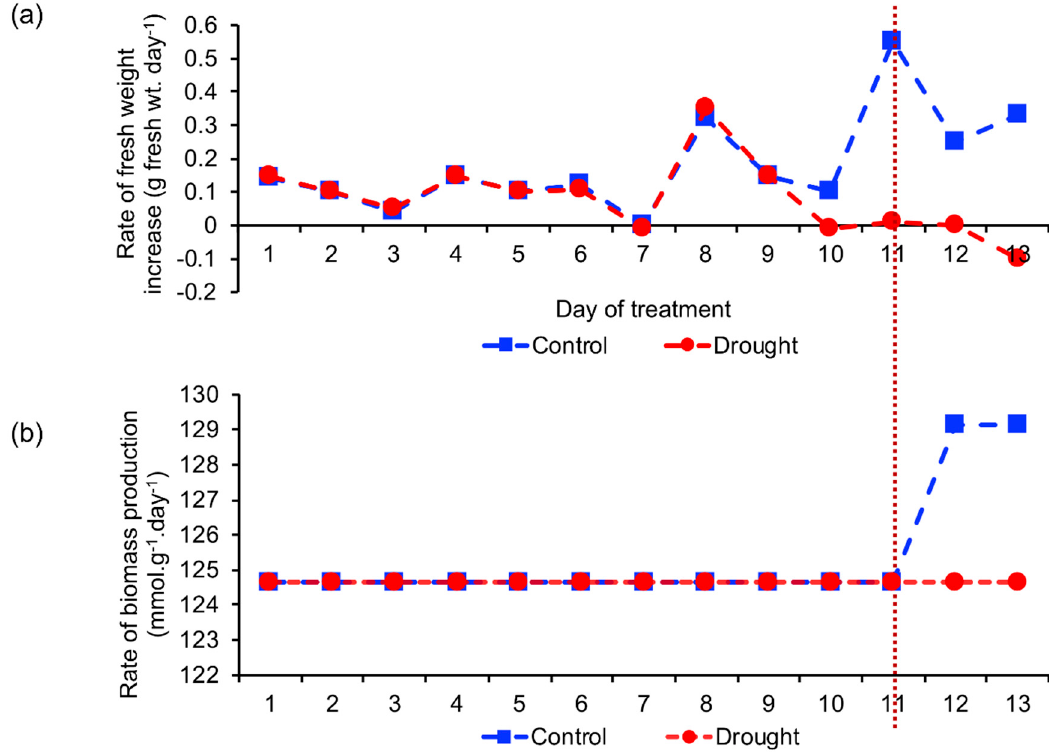
Figure 4. Comparison of estimated and actual biomass production rates: ( a ) Rate of fresh weight increase in rosette leaves in biological experiment [16] and ( b ) rate of biomass production calculated using the context-specific GEMs. Blue, control; red, drought.